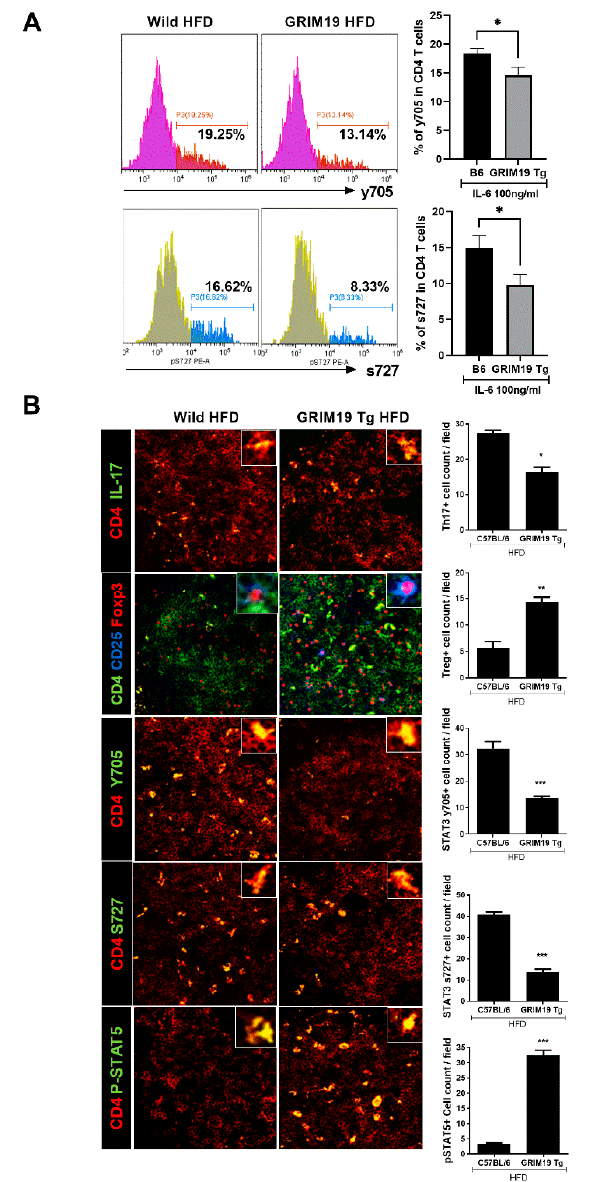
Figure 5. Effect of GRIM19 on Th17/Treg cell regulation in obese mice. ( A ) Representative flow cytometry plots showing the frequencies of CD4 + pSTAT3 (Tyr705) + and CD4 + pSTAT3 (Ser727) + cells in spleens from HFD-fed WT and GRIM19-Tg mice. Bar graphs show frequency of each cell type. ( B ) Representative confocal microscopy images of CD4 + IL-17 + cells and CD4 + CD25 + Foxp3 + , as well as CD4 + pSTAT3 (Tyr705) + , CD4 + pSTAT3 (Ser727) + , and CD4 + pSTAT5 + cells in spleens from HFD-fed WT and GRIM19-Tg mice. Bar graphs show the numbers of each cell type in four independent quadrants. Data are presented as the means ± SDs of three independent experiments. Scale bar, 20 µ m * p < 0.05, ** p < 0.01, *** p <